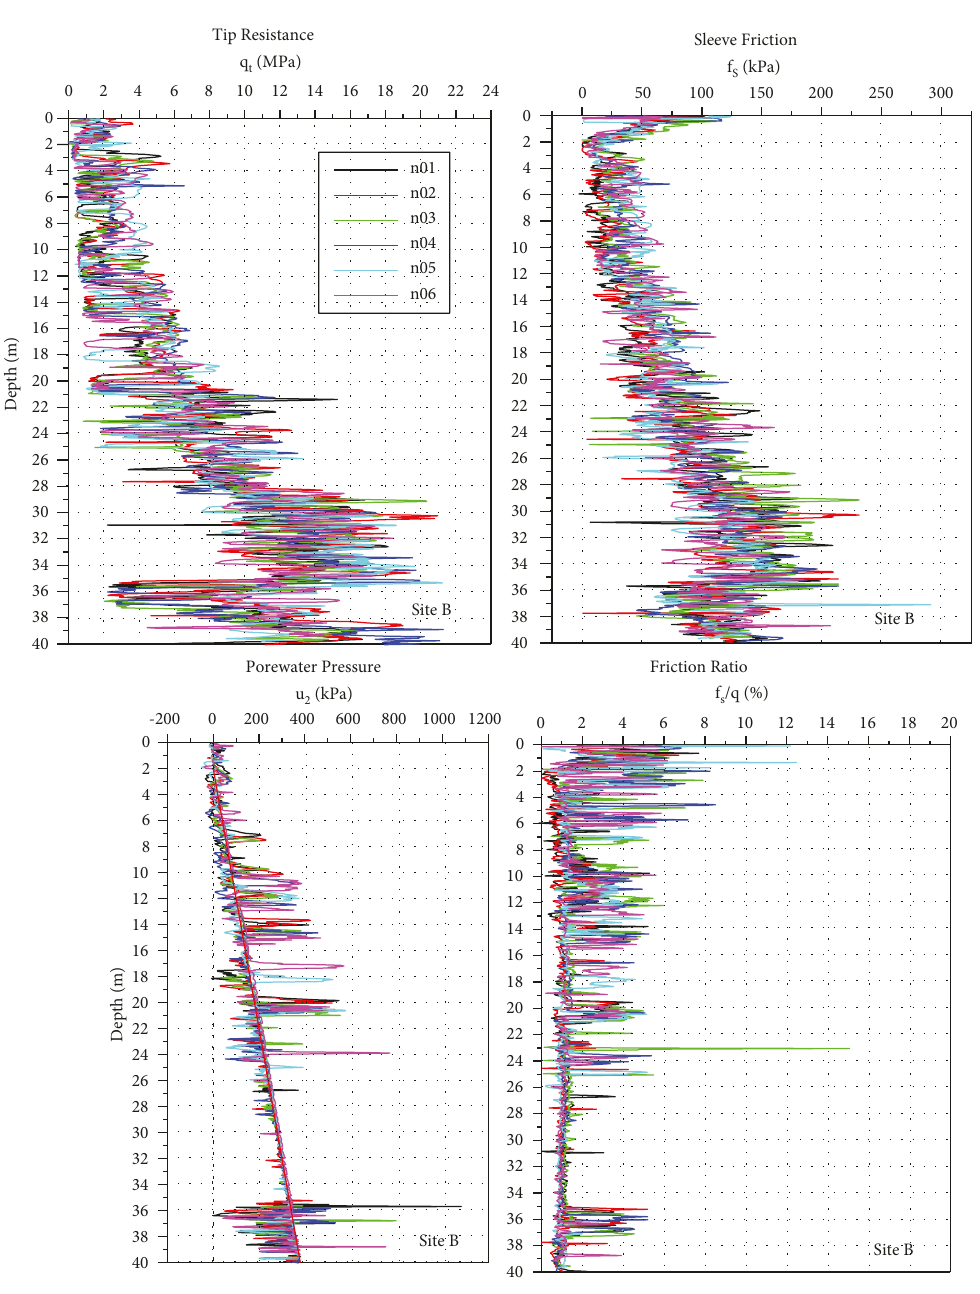
Figure 3: Series of piezocone penetration tests at the two